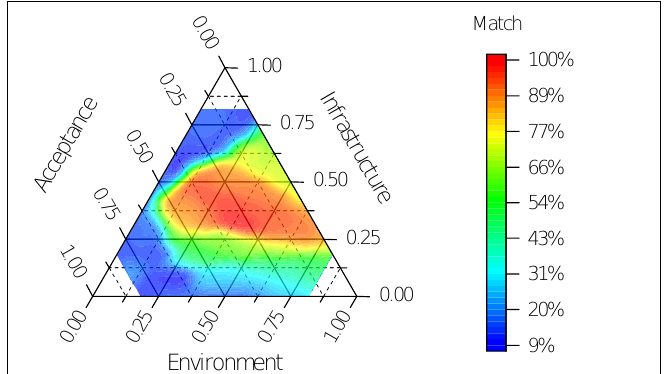
Figure 10. Influence of different weighting factors on similarity compared to the case with equally weighted influencing factors for the DC GER project. Own illustration.